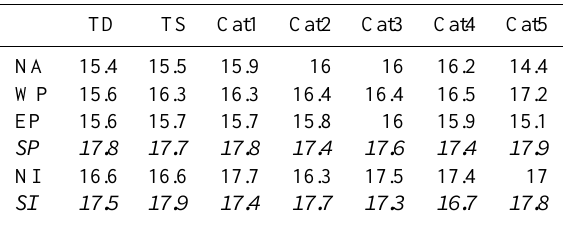
Table 2. Mean altitude (in km) of the lowest coldest point of temper- ature anomaly profiles for different ocean basins and different storm intensities. The Southern Hemisphere ocean basins are marked in italic.